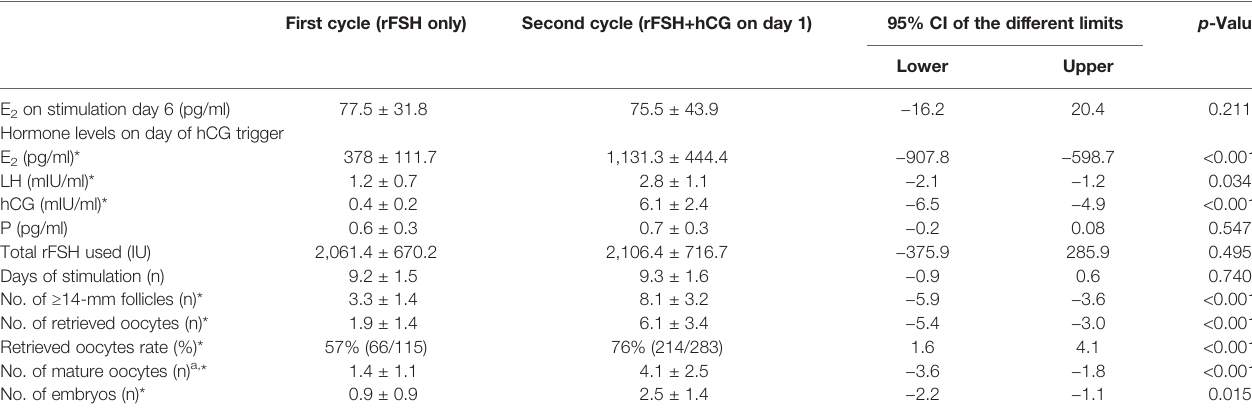
TABLE 2 | Self-comparison of OS characteristics in group A (n = 35) with and without hCG addition. First cycle (rFSH only) Second cycle (rFSH+hCG on day 1)